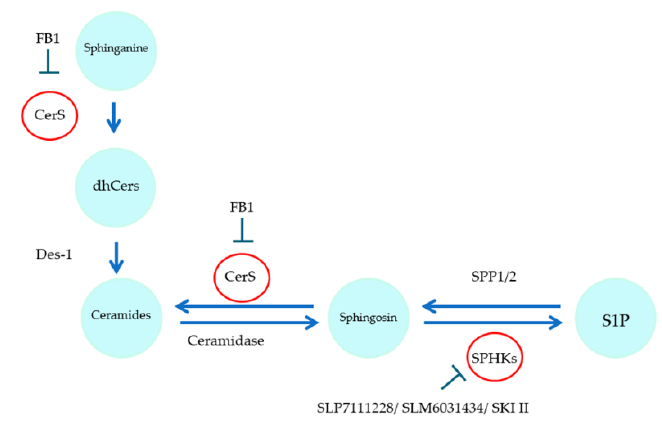
Figure 11. Simplified overview of the target enzymes affected by the inhibitors used.